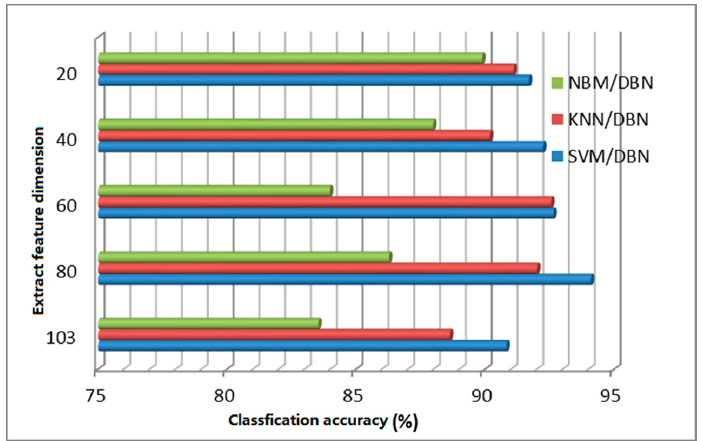
Figure 17. The classification accuracy of Deep Belief Networks (DBN) based on depth learning and other algorithms.